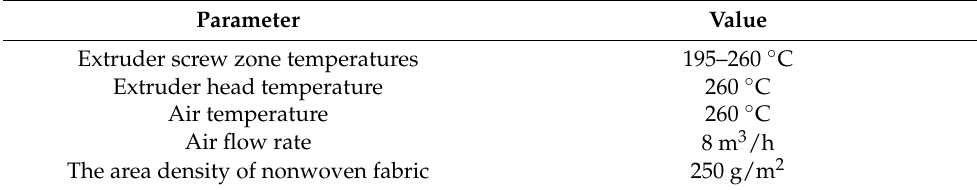
Table 1. Processing parameters of the melt blown process.